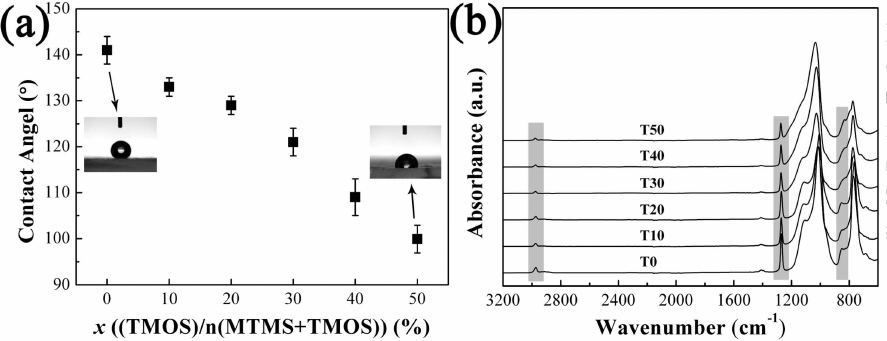
Figure 5. The contact angle of water droplet ( a ) and FTIR-ATR spectra of all the samples ( b